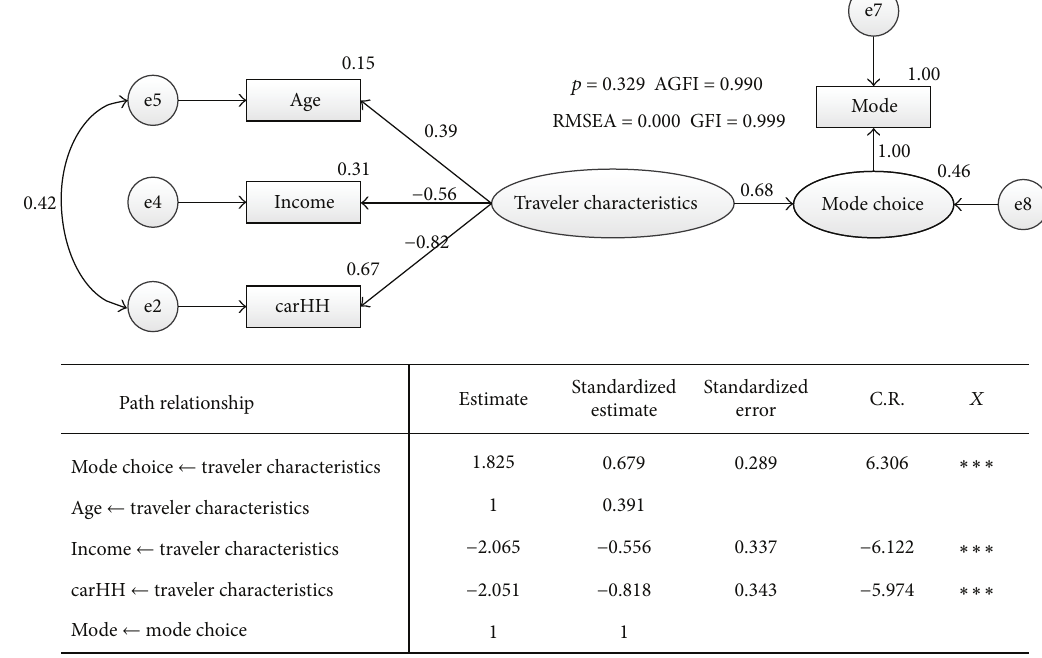
Figure 5: Effect of travelers’ characteristics on mode choice.